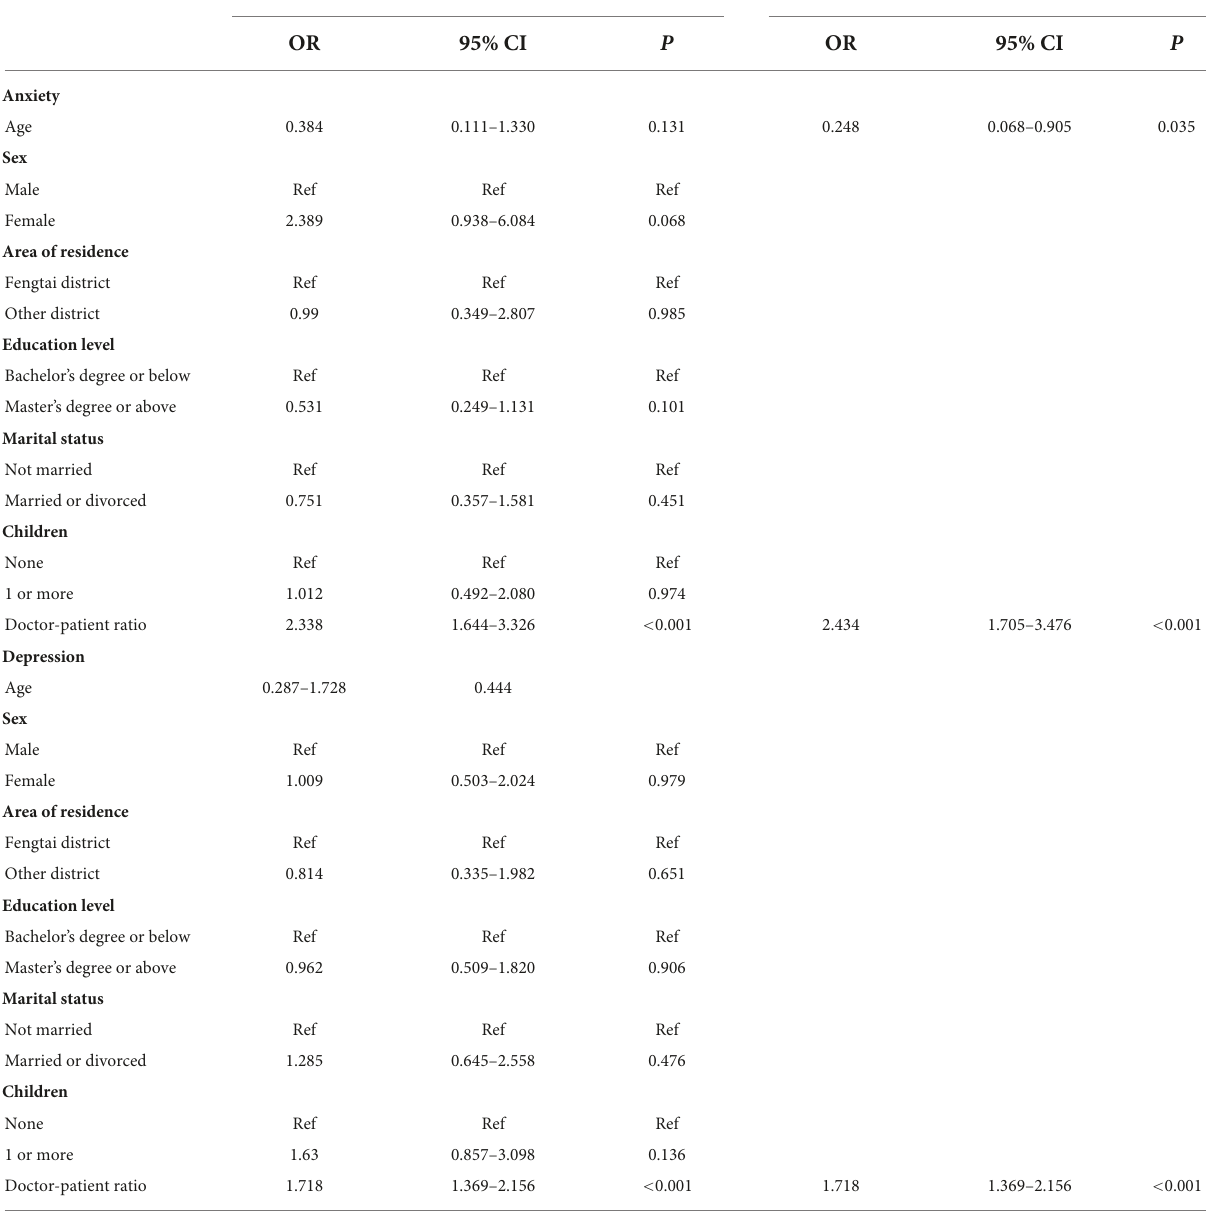
TABLE 3 Factors influencing anxiety and depression status in univariate and multivariate logistic regression models. Univariate logistic regression model Multivariate logistic regression